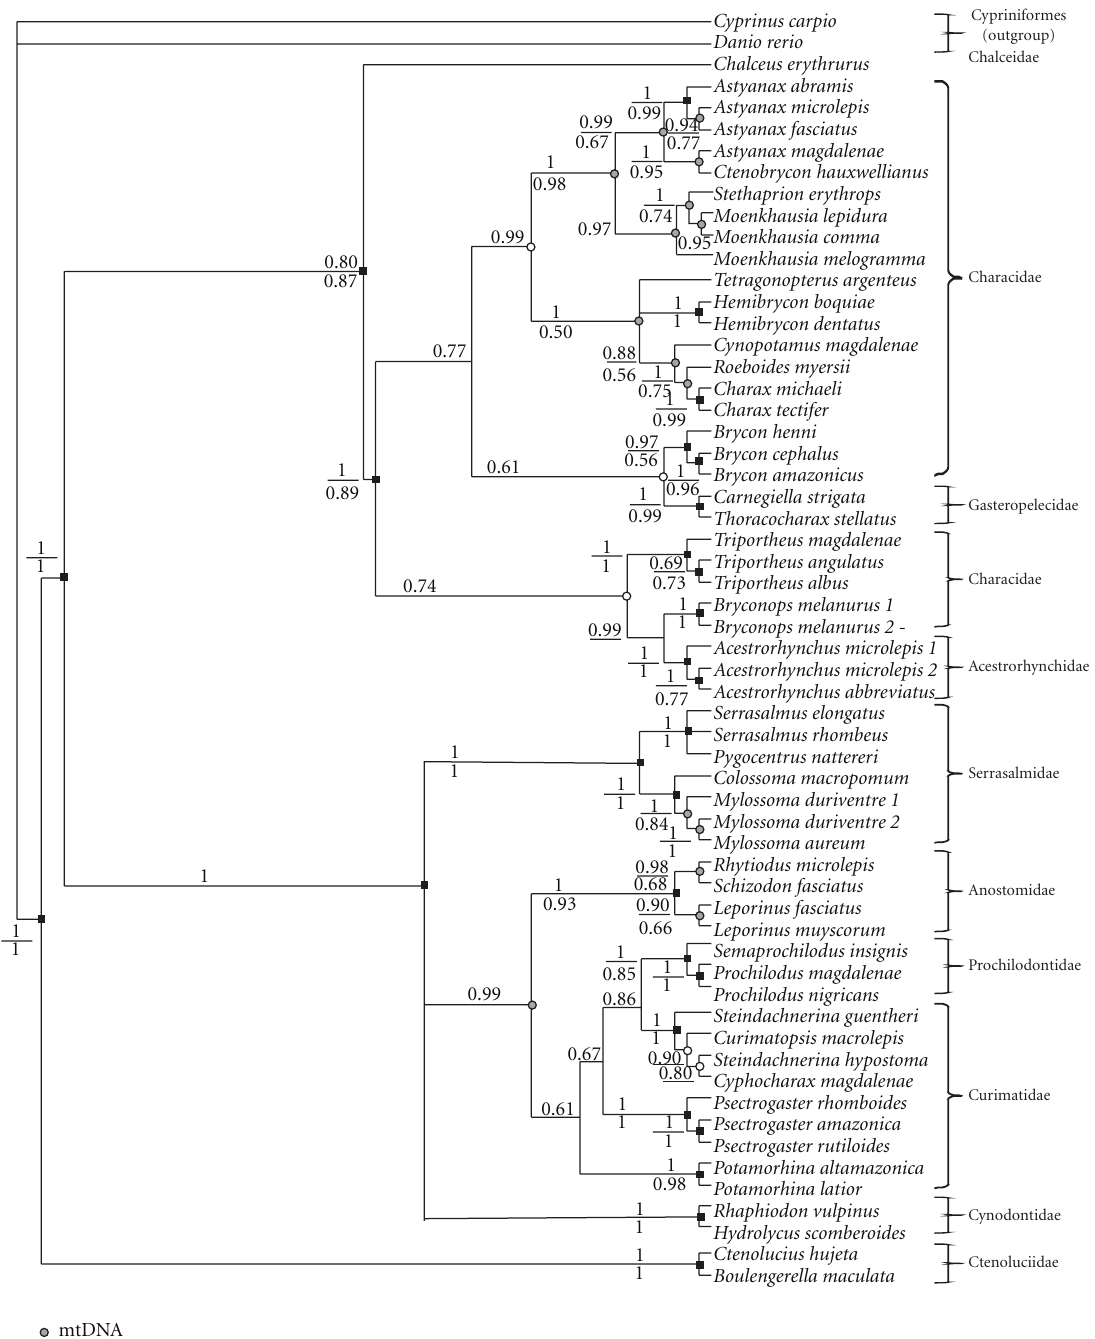
Figure 4: Phylogeny of the order Characiformes based on combined Bayesian analysis of 16S rDNA and 18S rDNA. Values above branches indicate Bayesian posterior probability (posterior probability > 0.5), while those below branches indicate parsimony bootstrap proportions for concordant clades (bootstrap value > 50%). Nodes that were also recovered in separate Bayesian analyses of mitochondrial and/or nuclear data are labeled with symbols. Unlabeled nodes were unique to combined data